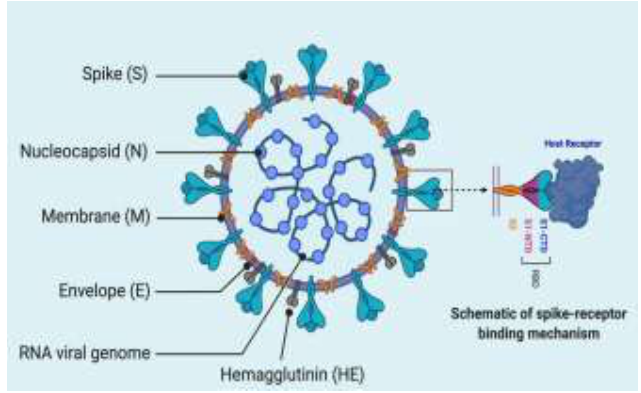
Fig. 1. Coronavirus structure and spike protein binding to host cell receptor (the figure was made using